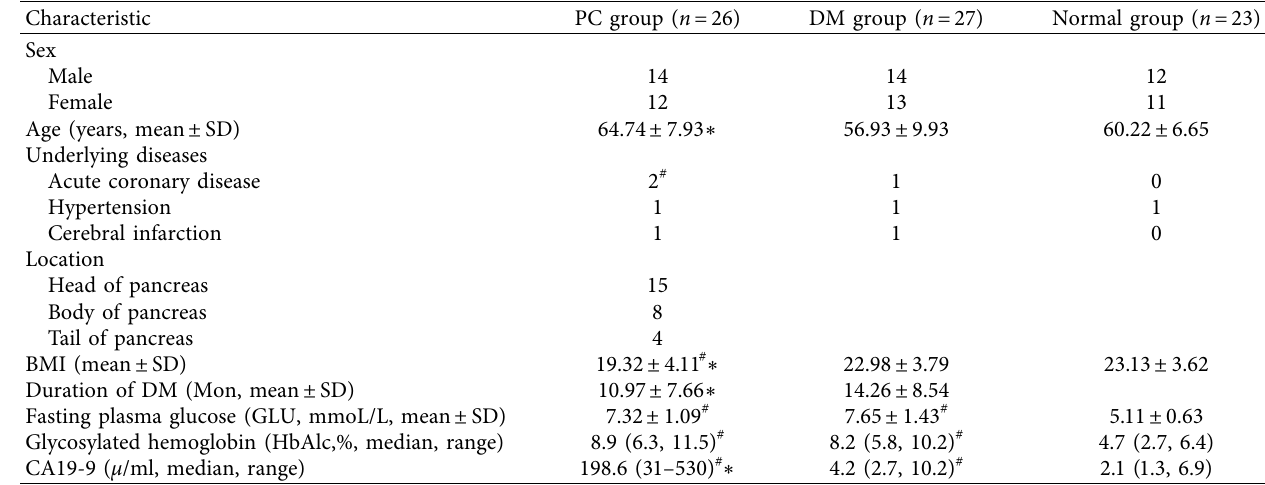
Table 1: Demographic data of